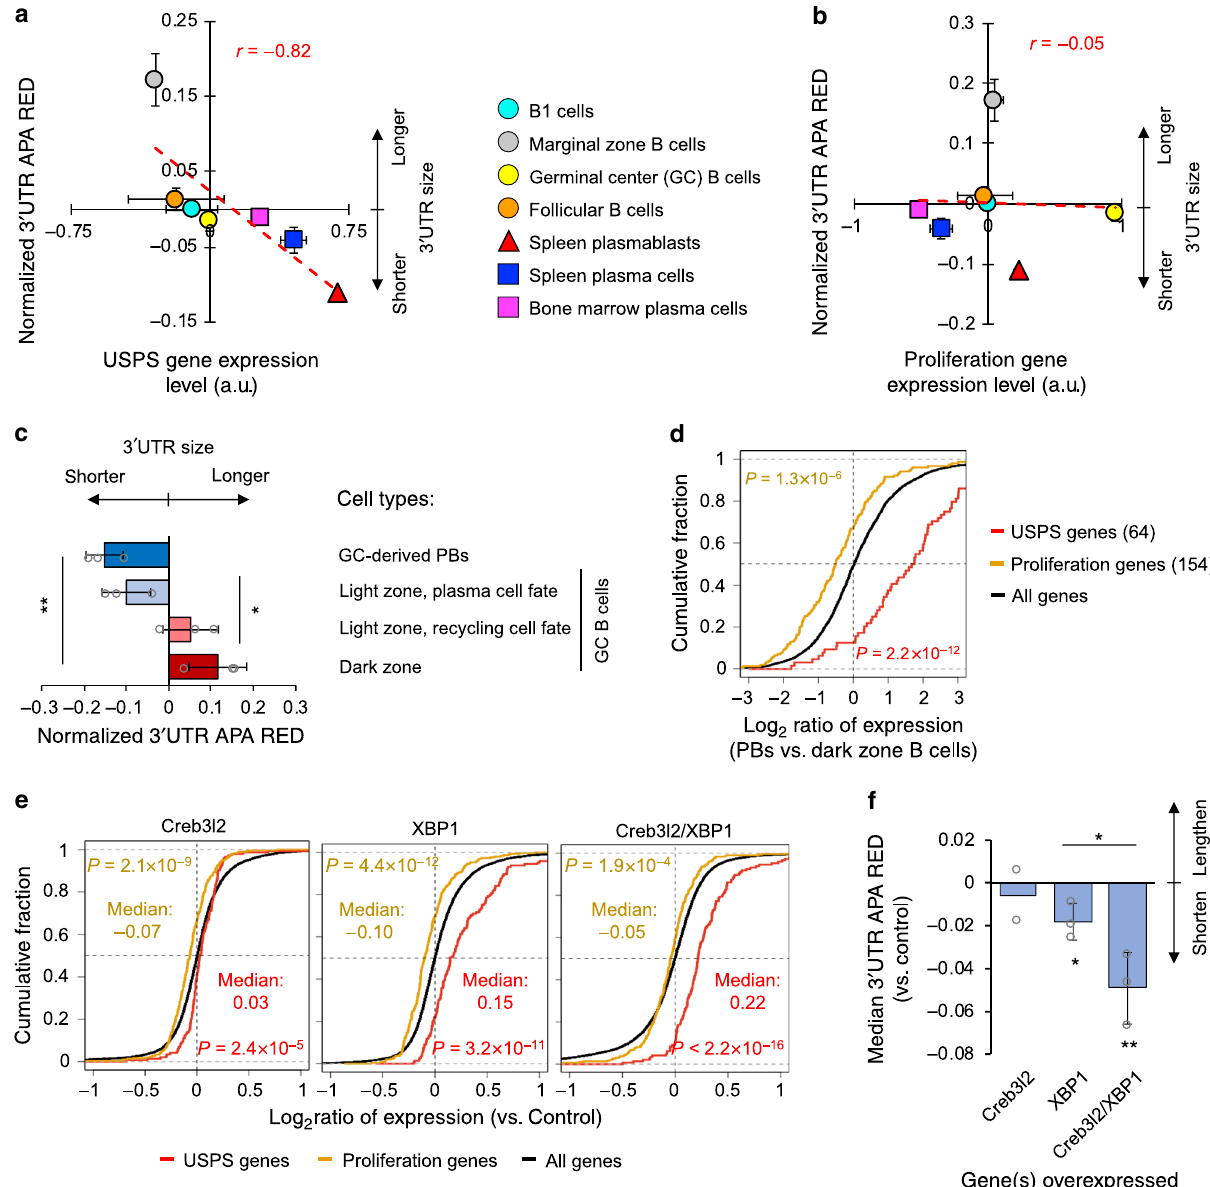
Fig. 7 Additional systems supporting SCAP. a Correlation between 3 ʹ UTR APA REDs and USPS gene expression levels across different types of B cells and plasma cells (a study by Shi et al. 43 ). 3 ʹ UTR APA REDs are normalized to the median of all samples. Pearson correlation coef fi cient ( r ) is indicated. There are two samples for each cell type except for spleen plasmablasts (1 sample), spleen plasma cells (3 samples), and bone marrow plasma cells (1 sample). Data are presented as mean value + / − SD. a.u., arbitrary unit. b As in a , except that correlation between 3 ʹ UTR APA REDs and proliferation gene expression level is shown. c 3 ʹ UTR APA REDs for different types of B cells in the germinal center (GC) and GC-derived plasmablast (PB)(a study by Ise et al. 44 ). 3 ʹ UTR APA REDs are normalized to the median of all samples. Data are presented as mean value + / − SD of three replicates. Signi fi cance of difference ( t -test) between cell groups is indicated. Plasma cell fate B cells in the light zone are Bcl6 low and CD69 high cells, and recycling cell fate B cells are Bcl6 high and CD69 high cells. d CDF curves of gene expression changes for USPS (red) and proliferation (orange) genes in GC-derived PBs vs. dark zone B cells. Number of genes in each set is indicated. P -values (K – S test) for signi fi cance of difference between each gene set and all genes are indicated. e CDF curves of gene expression changes for USPS genes (red, 145), proliferation genes (orange, 298), and all genes in AtT-20 cells with overexpression of indicated gene(s) vs. control cells (a study by Khetchoumian et al. 45 ). P -values (K – S test) for signi fi cance of difference between gene sets are indicated. f Bar plot of median 3 ʹ UTR APA REDs for the samples in e . Data are presented as mean value + / – SD based on two (Creb3l2) or three (XBP1 and Creb3l2/ XBP1) replicates. Signi fi cance of difference ( t -test) vs. control or between cell groups is Fig. 7e, left). By contrast, XBP1 OE, which upregulates endo- indicating synergy between these two factors. Consistent with the plasmic reticulum (ER) biogenesis 45 , led to signi fi cant upregula- SCAP model, 3 ʹ UTR shortening was signi fi cant in cells with tion of USPS genes (median log 2 Ratio = 0.15, Fig. 7e, middle). XBP1 OE and co-OE of XBP1 and Creb3l2 (Fig. 7f), with the latter being greater in magnitude than the former. By contrast, Interestingly, co-OE of both factors led to the greatest upregu- Creb3l2 OE did not elicit signi fi cant 3 ʹ UTR shortening (Fig. 7f). lation of USPS genes (median log 2 Ratio = 0.22, Fig. 7e, right),